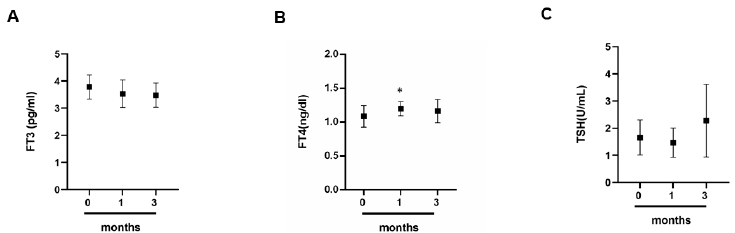
Figure 4. Hormonal dosage. ( A ) fT3 ( B ) fT4 ( C ) TSH evaluation of thyroid hormones in professional athletes at different times 0, 1 and 3 months by a group of 12 professional basketball athletes. Data expressed as the mean ± SD. Significance determined by the t- test student; ( B ) 0 months versus 1 months * ( p = 0.0481). fT3, triiodothyronine; fT4, thyroxine; TSH, thyroid stimulating hormone.